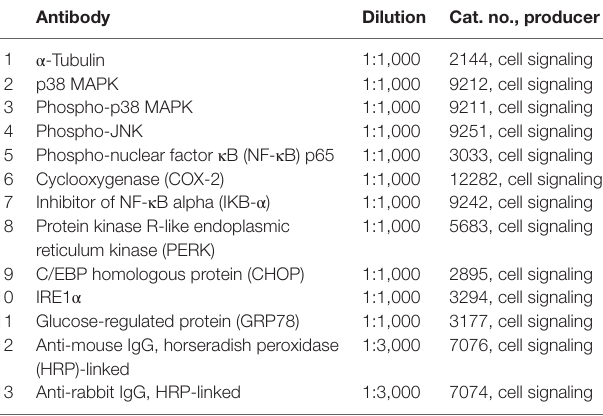
TaBle 3 | Primary and secondary antibodies used for immunoblotting.